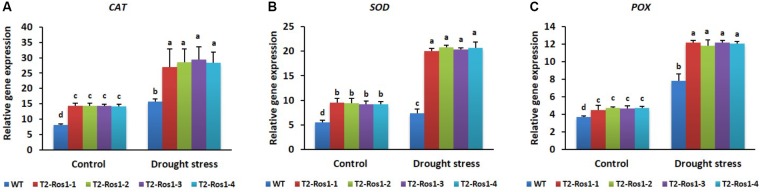
Expression analysis of the antioxidant-related genes (A, CAT; B, SOD; C, POX) in the 8-week-old WT and four independent T2-Ros1 lines under drought stress and normal growth conditions. Data were taken on the 15th day after starting the experiments. NtActin gene was used as reference gene to normalize the transcript levels of the genes. Error bars indicate the SE of means of three replicates. Means with different letters are significantly different (DMRT, p < 0.05).